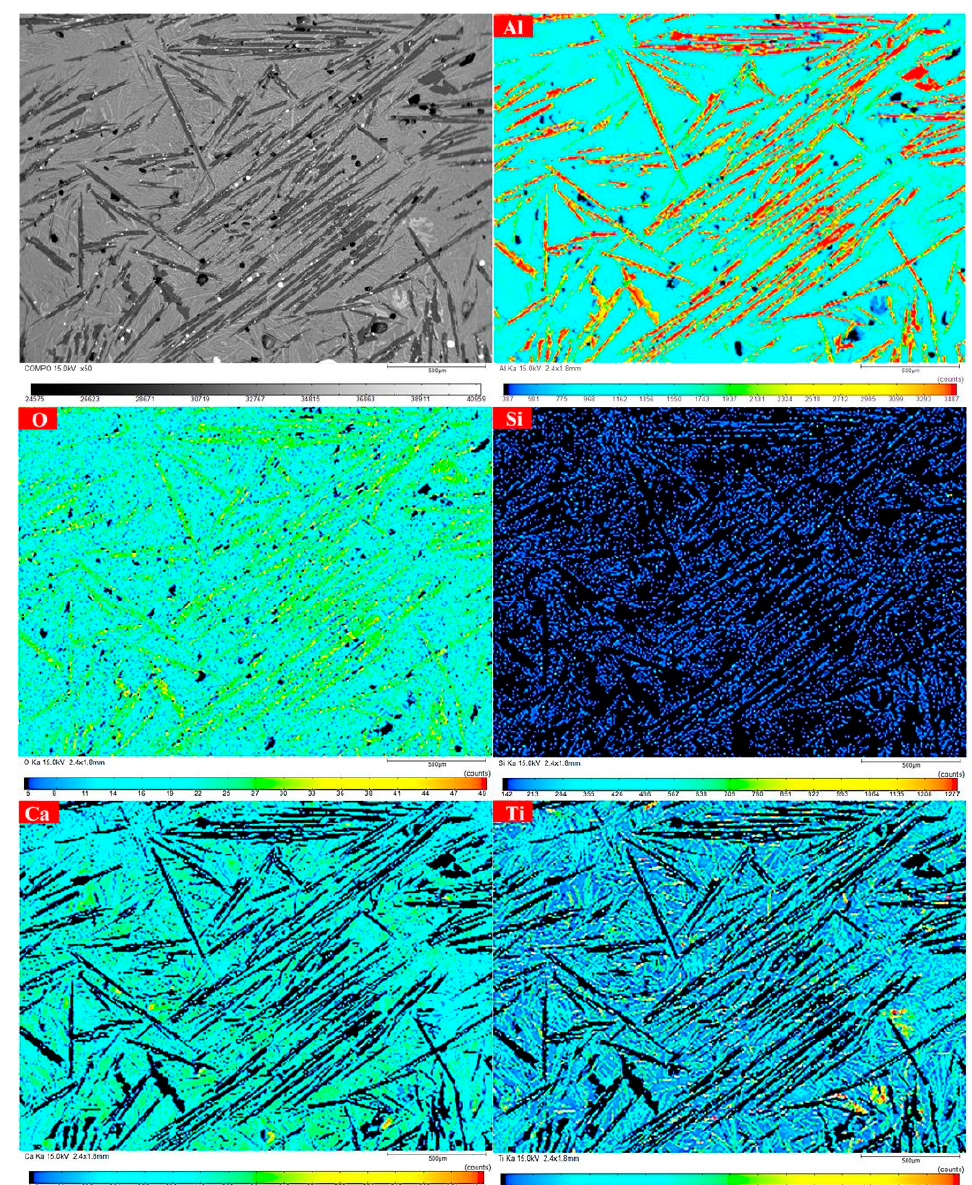
Figure 2. EPMA of the SSS.